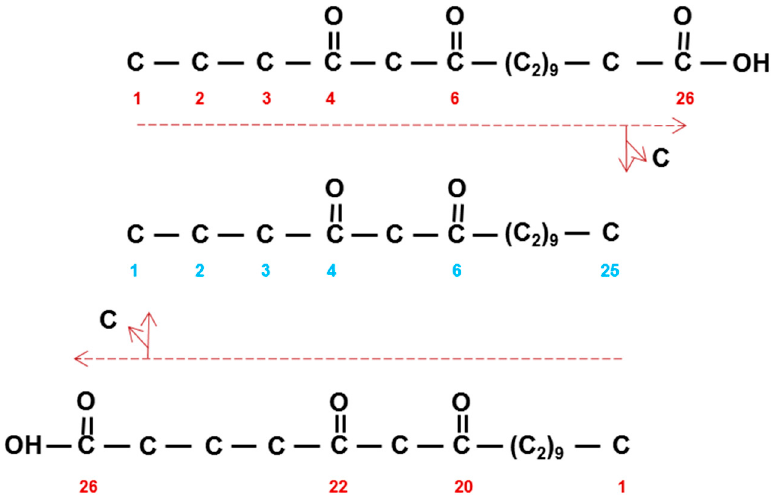
Figure 6. Nomenclature and possible synthesis of the carbon skeleton of pentacoasane-4,6-dione (middle). Synthesis (horizontal red arrows and numbers) in direction of (top) and in opposite direction of (bottom) IUPAC nomenclature (blue numbers). Vertical arrows show loss of carbon to give the C 25 dione.